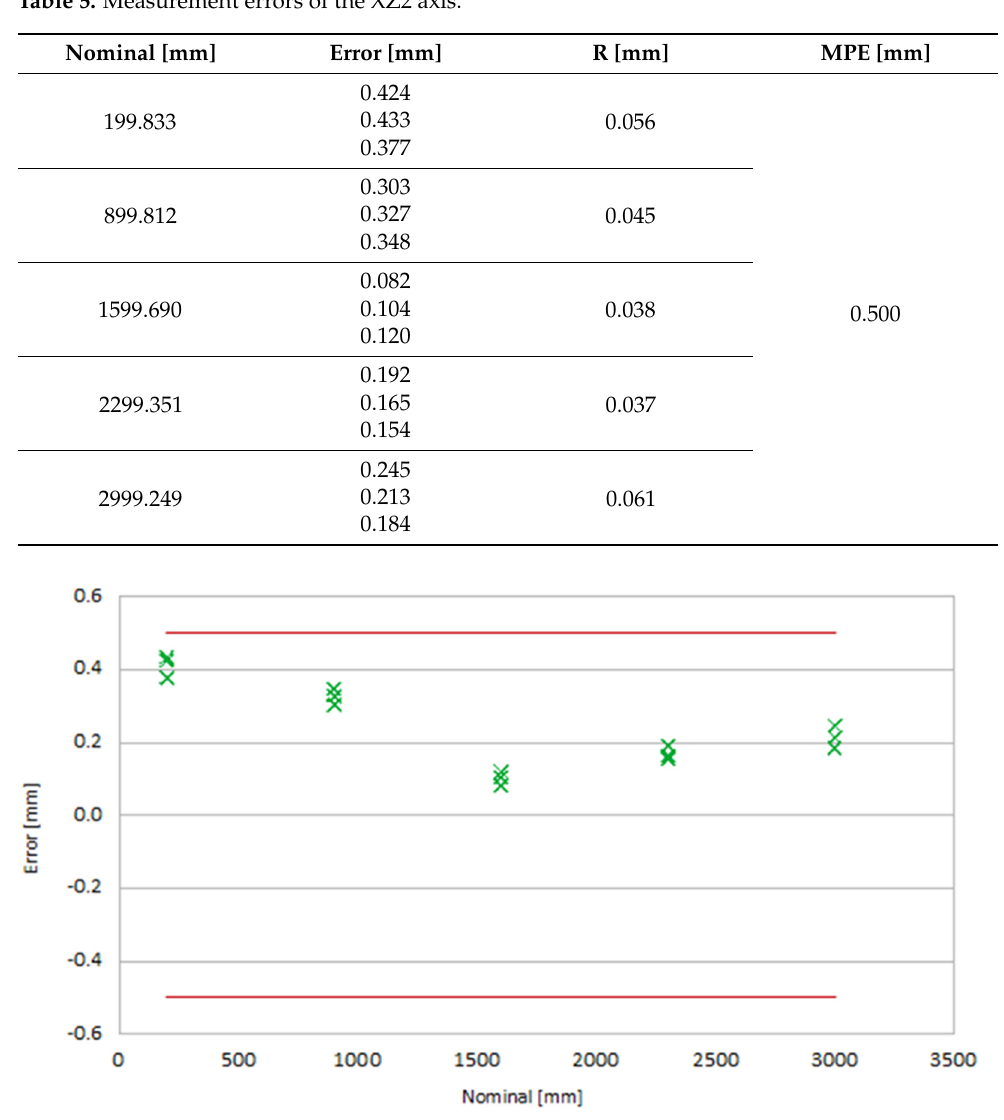
Figure 10. XZ2 − axis measurement error characteristic.